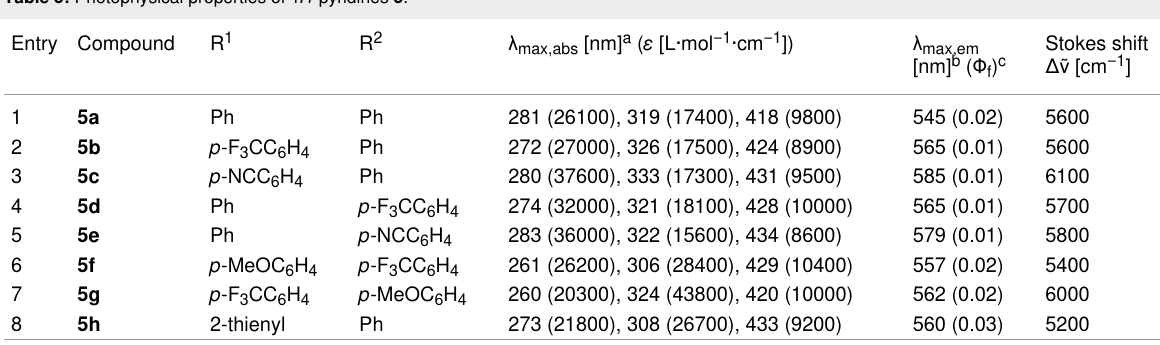
Table 5: Photophysical properties of 1 H -pyridines 5